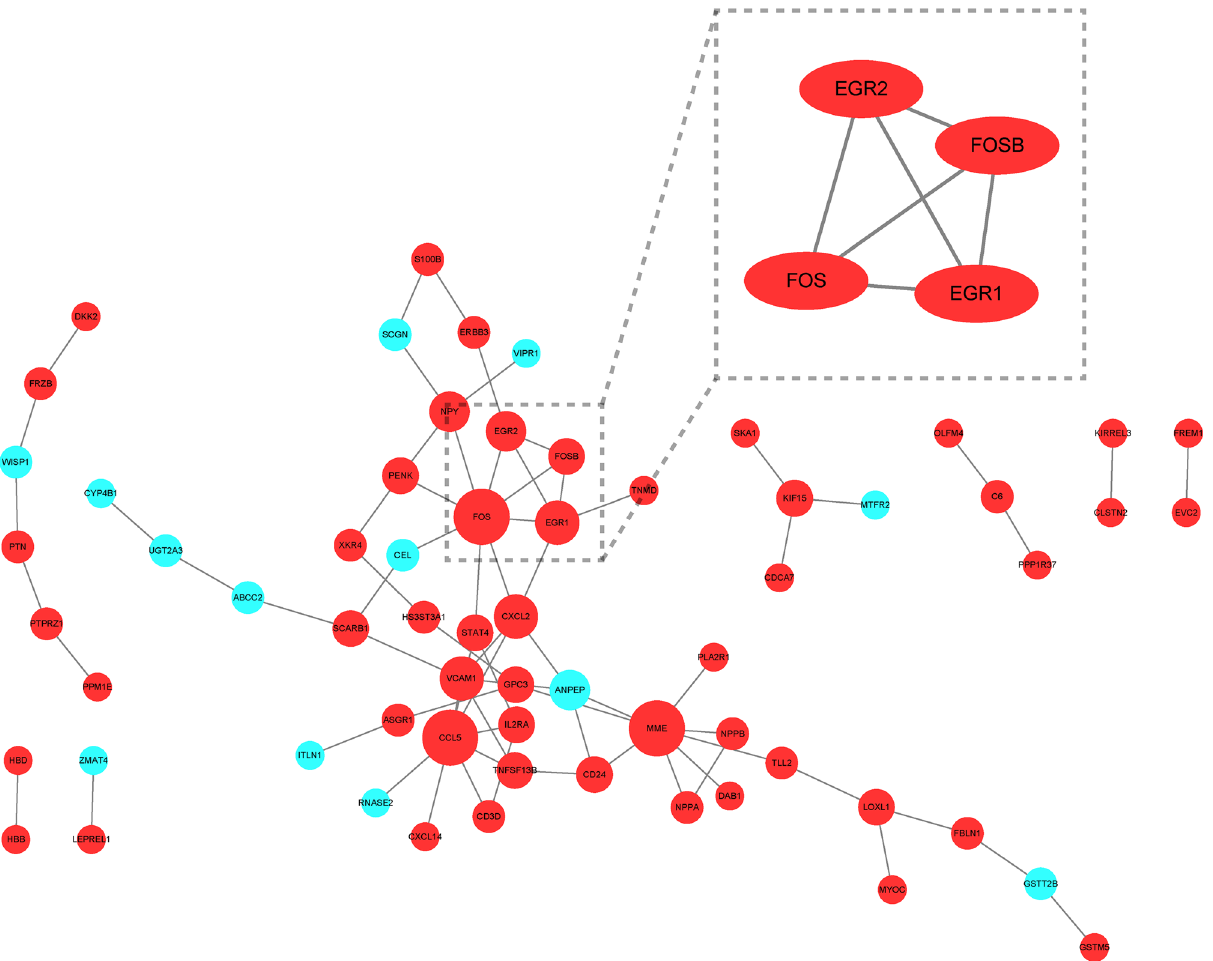
Figure 7. PPI network construction. (Red represents up-regulated genes, blue represents down-regulated